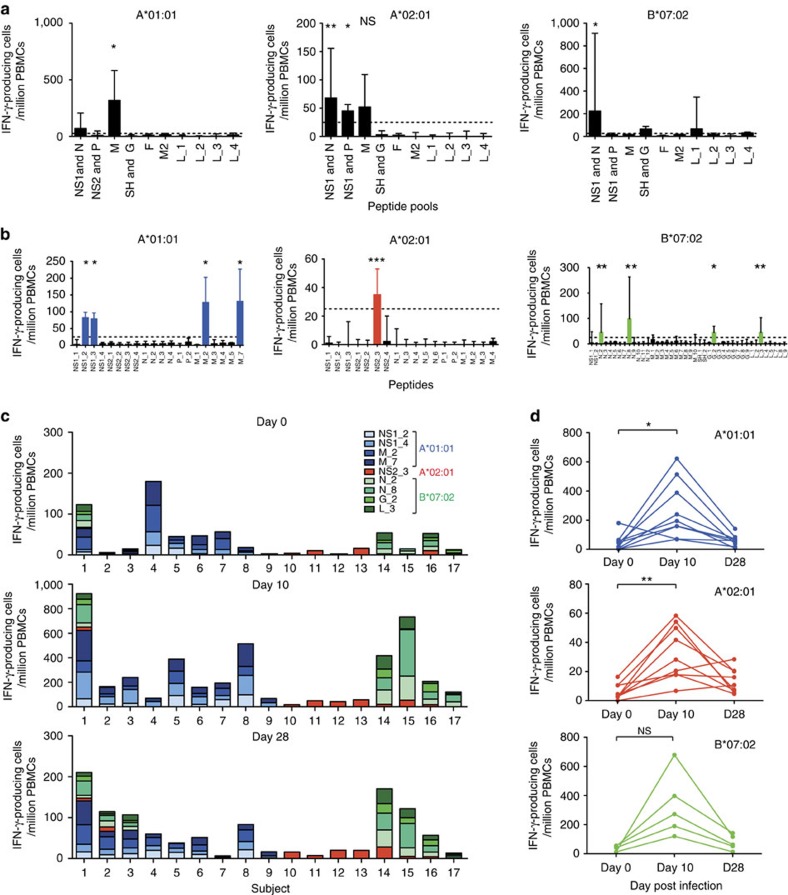
Immunodominance hierarchies in MHC class-I-restricted RSV epitope-specific CD8+ T-cell responses.Epitopes were predicted in silico for binding and used to stimulate day 10 PBMCs from HLA-matched infected volunteers with sufficient cells (HLA A*01:01, n=4; A*02:01, n=5; and B*07:02, n=4) in interferon-γ (IFN-γ) ELISpot assays. (a) Peptides were pooled according to their originating RSV protein. Two-tailed Mann–Whitney tests were carried out between peptide pools and negative control wells (A*01:01_NS1/N, P=0.0286; A*02:01_NS1/N, P=0.0079; A*02:01_NS2/P, P=0.0119; and B*07:02_NS1/N, P=0.0286). (b) Individual peptides from positive pools were subsequently tested separately. Dotted lines represent a cutoff of 25 spots per 106 PBMCs. Means±s.e.m. and P values for unpaired Mann–Whitney tests are shown (A*01:01_NS1_2, P=0.0286; A*01:01_NS1_4, P=0.0286; A*01:01_M_2, P=0.0294; A*01:01_M_7, P=0.0294; A*02:02_NS2_3, P=0.0002; B*07:02_N_2, P=0.0079; B*07:02_N_8, P=0.0079; B*07:02_G_2, P=0.0278; and B*07:02_L_3, P=0.0079). (c) The median frequencies of IFN-γ+ cells in response to individual RSV epitopes presented by HLA-A*01:01 (blues), A*02:01 (reds) and B*07:02 (greens) are shown in 17 HLA-matched RSV-infected individuals at day 0, 10 and 28 post infection. (d) The frequencies of median total IFN-γ-producing cells at baseline, day 10 and day 28 post infection in response to HLA-A*01:01 (blue)-, A*02:01 (red)- and B*07:02 (green)-restricted epitopes in 17 HLA-matched infected individuals are shown. P values for Wilcoxon matched pairs tests are shown (A*01:01, P=0.0117; A*02:01, P=0.0039; and B*07:02, P=0.125; NS (not significant)=P>0.05, *P<0.05, **P<0.01, ***P<0.001).